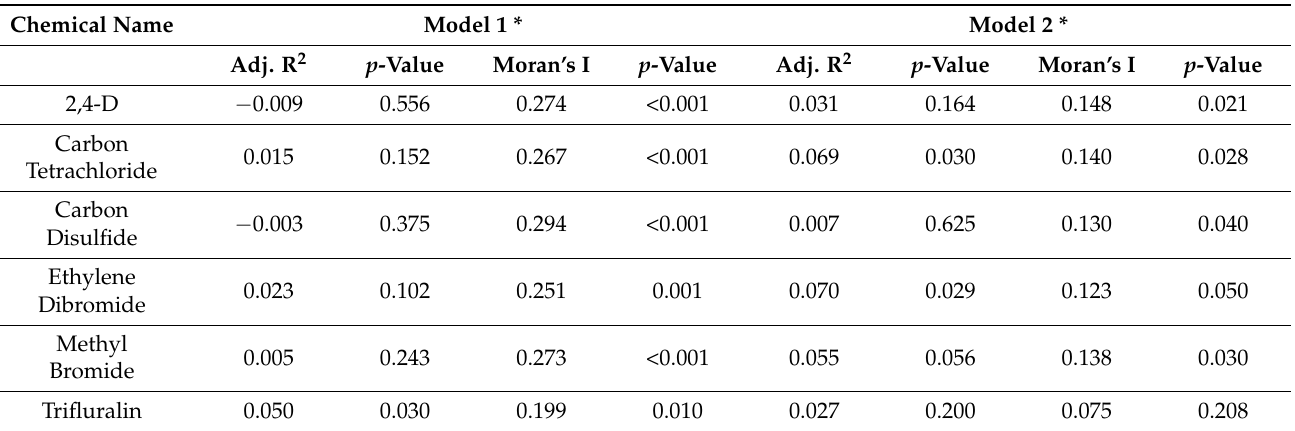
Table 1. Ordinary least square regression for the relationship between selected agricultural chemicals and CRC at the county level. Global Moran’s I results of spatial autocorrelation on OLS residuals.